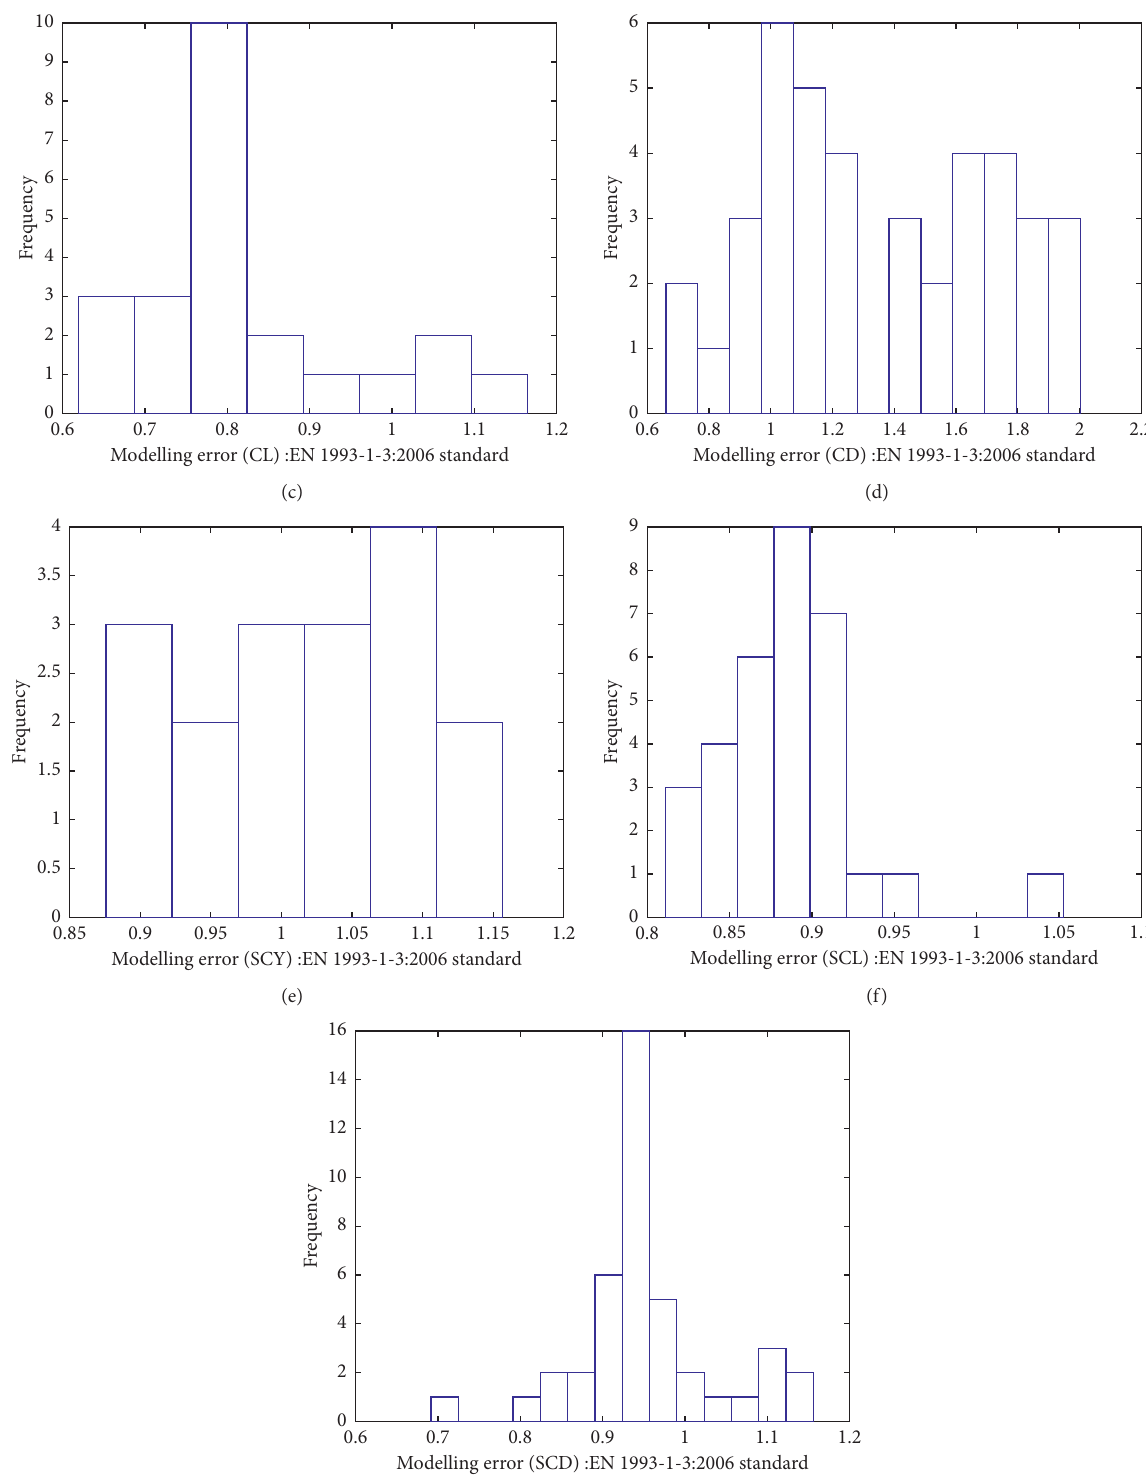
Figure 7: ME histograms for various failure modes for database member as per AISI S100-16 & AS/NZS 4600: 2018 Standards. (a) CF—column flexure; (b) CFT—column flexure-torsion; (c) CL—column local buckling; (d) CD—column distortion buckling; (e) SCY—stub column yielding; (f) SCL—stub column local buckling; (g) SCD—stub column distortion